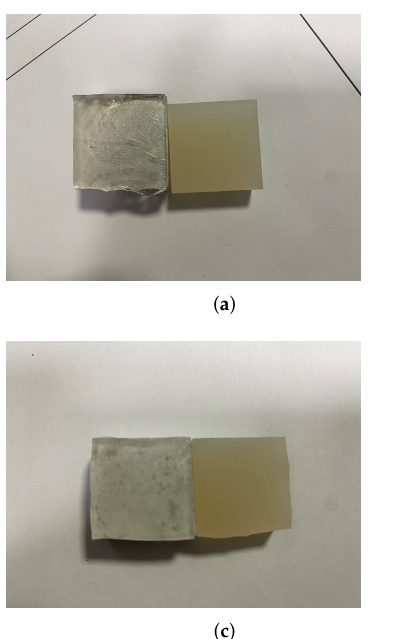
Figure 3. Section view of tensile shear disruption of AL-Ice-AL specimens. ( a ) Experimental section of specimen frozen for 6 h at − 15 ◦ C. ( b ) Experimental section of specimen frozen for 2 h at − 25 ◦ C. ( c ) Experimental section of specimen frozen for 2 h at − 55 ◦ C.